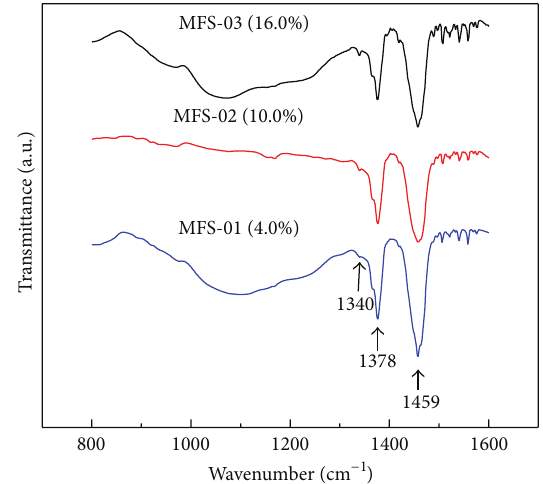
Figure 4: FT-IR spectra of MFSs with various dosage of SURFLON S-386 (a: MFS-01; b: MFS-02; c: